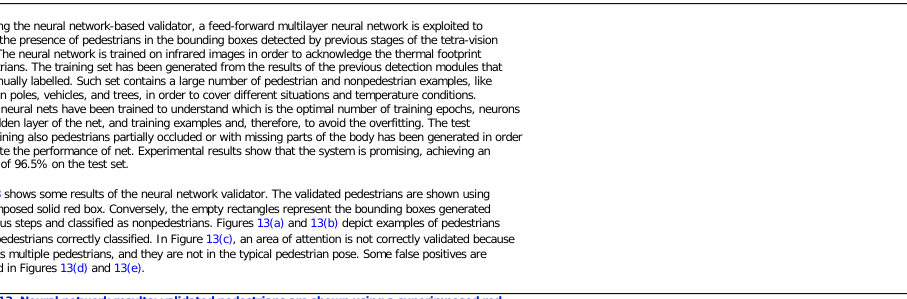
Figure 13 Neural network results: validated pedestrians are shown using a superimposed red box; the white rectangles represent the discarded bounding